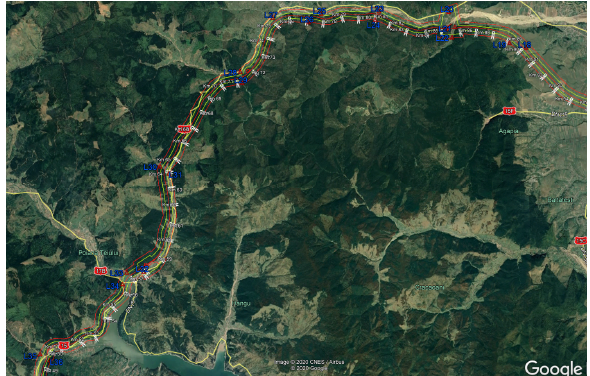
Figure 18 . Ground control points for geoid adjustment (Union Highway, km 50 - km 94)